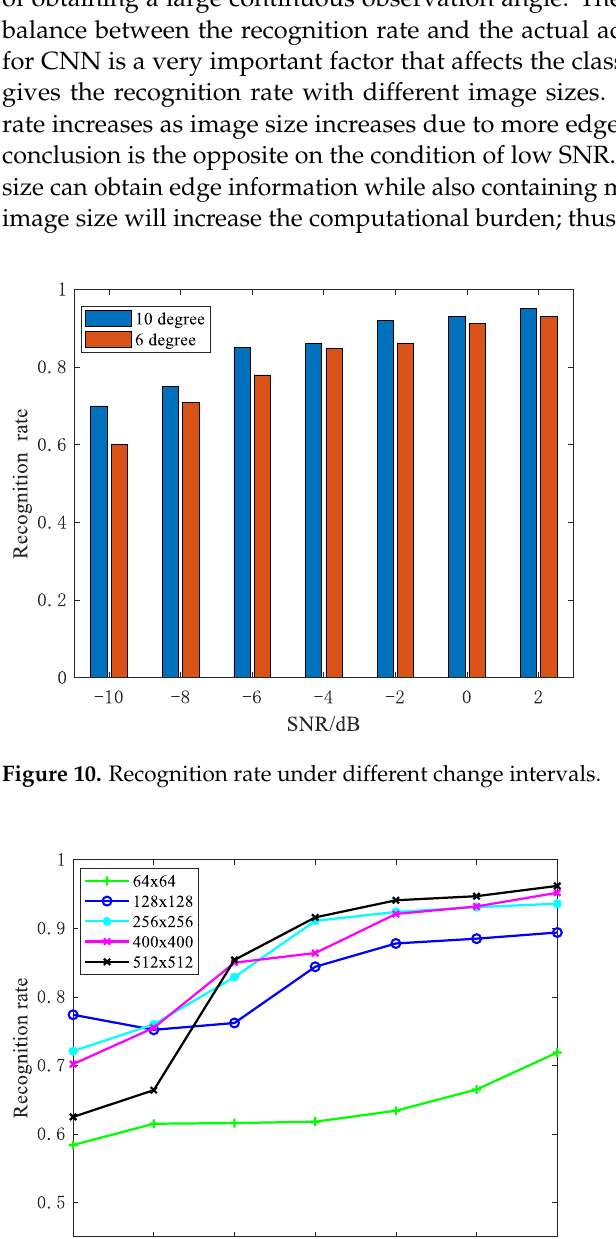
13 of 17 Figure 9. Recognition rate of the three vehicles: ( a ) before the two-dimensional variational mode decomposition (2D- IVMD) procedure and ( b ) after the 2D-IVMD procedure. Table 3. Parameters of vehicles and radar in the experiments. Simulation Parameters